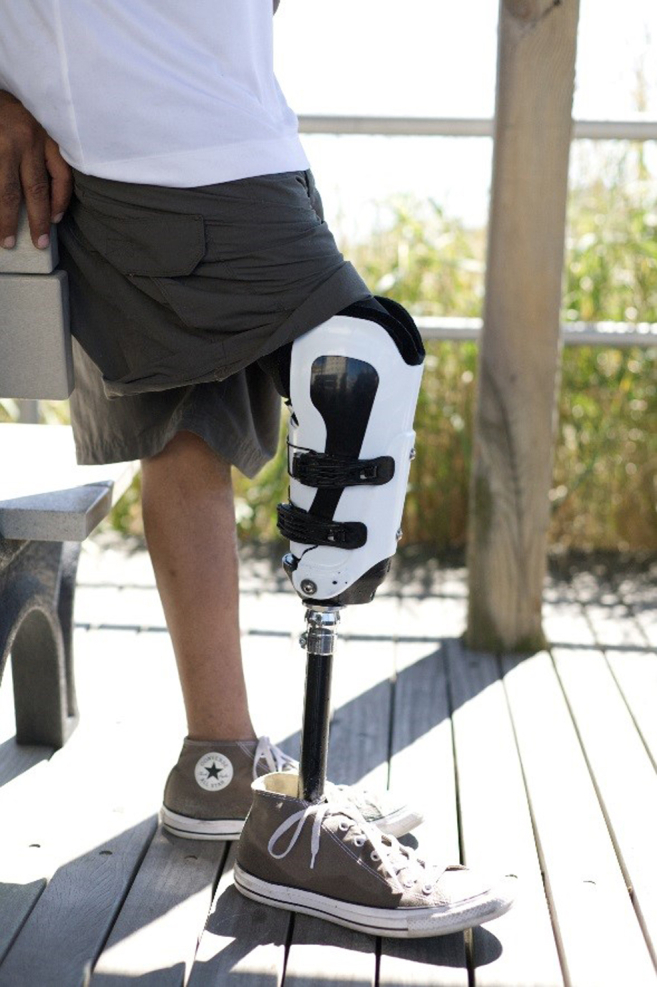
Lateral view of the iFIT prosthesis showing locking buckle closure system.